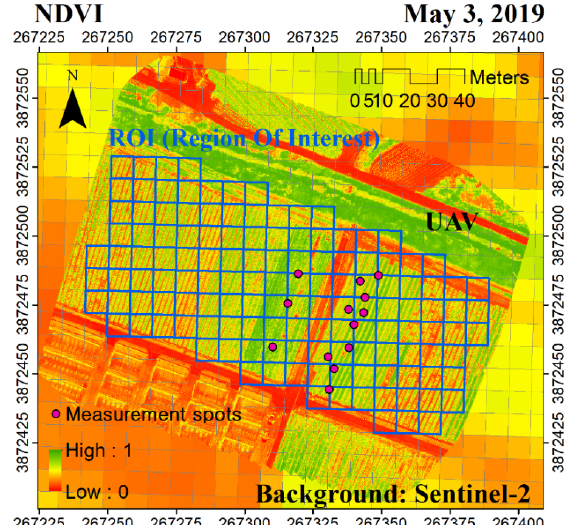
Figure 2. Sentinel-2 and UAV-based normalized difference vegetation index (NDVI) maps for 3 May 2019. The gray grid indicates the pixel boundaries of Sentinel-2 and the blue grid indicates the ROI used to compare the NDVI UAV and NDVI Sentinel-2 data.